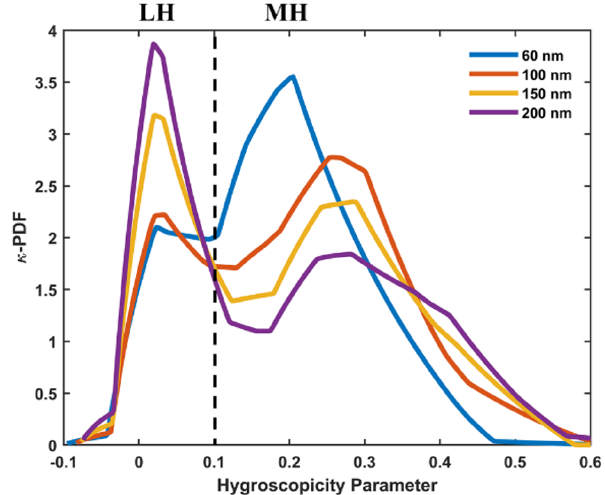
Figure 2. The average hygroscopicity parameter probability den- sity functions ( κ -PDF) for 60, 100, 150, and 200nm sized particles over the entire campaign. Two hygroscopic modes of the particles are defined: κ < 0 . 1 as the less hygroscopic (LH) mode and κ > 0 . 1 as the more hygroscopic (MH)